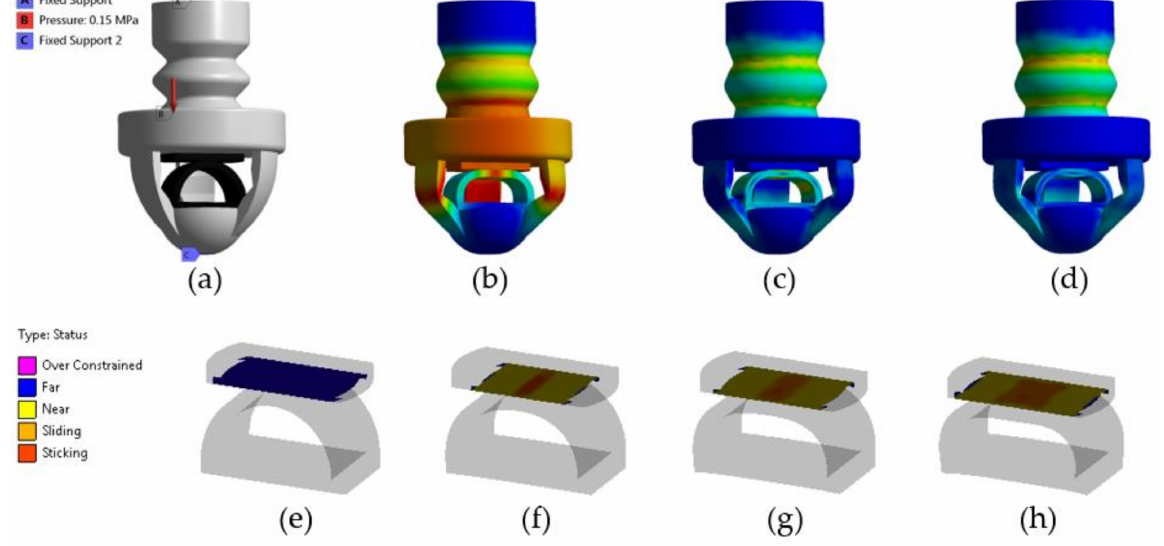
Figure 2. FEM results of SoHapS: ( a ) boundary conditions (A and C were fixed) at pressure of 150 kPa (B) applied to the internal walls; ( b ) deformation (max deformation in red, 1.583 mm); ( c ) equivalent stress (max stress in red, 3.628 MPa); and ( d ) equivalent strain (max strain in red, 26%). Changes in contact status of soft force sensor at ( e ) 0 kPa, ( f ) 50 kPa, ( g ) 100 kPa, and ( h ) 150 kPa pressure applied to